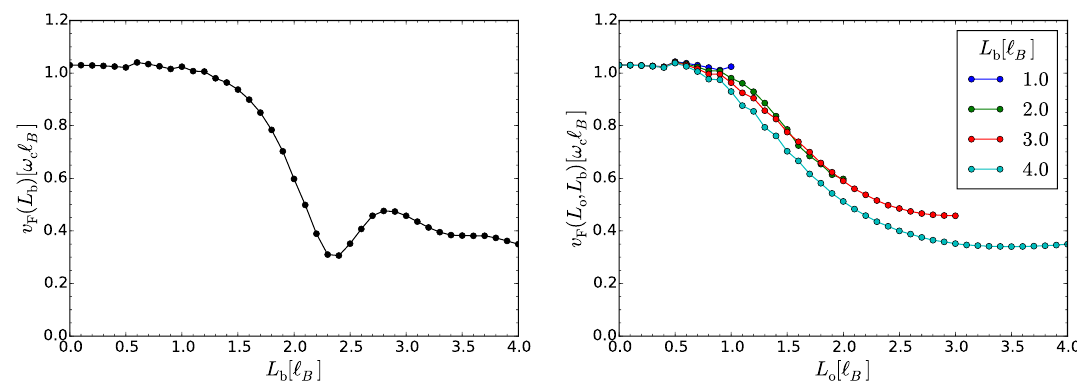
Figure 11: Left panel: Fermi velocity v of the right moving modes as function of the bay F = 10 µ m, L = 4.01 µ m, (cid:96) = 1 µ m, and L size L with at L y x p B b velocity v as a function of the opening L of the bays for various bay sizes L F o = 4.01 µ m, and (cid:96) = 1 µ L x p B